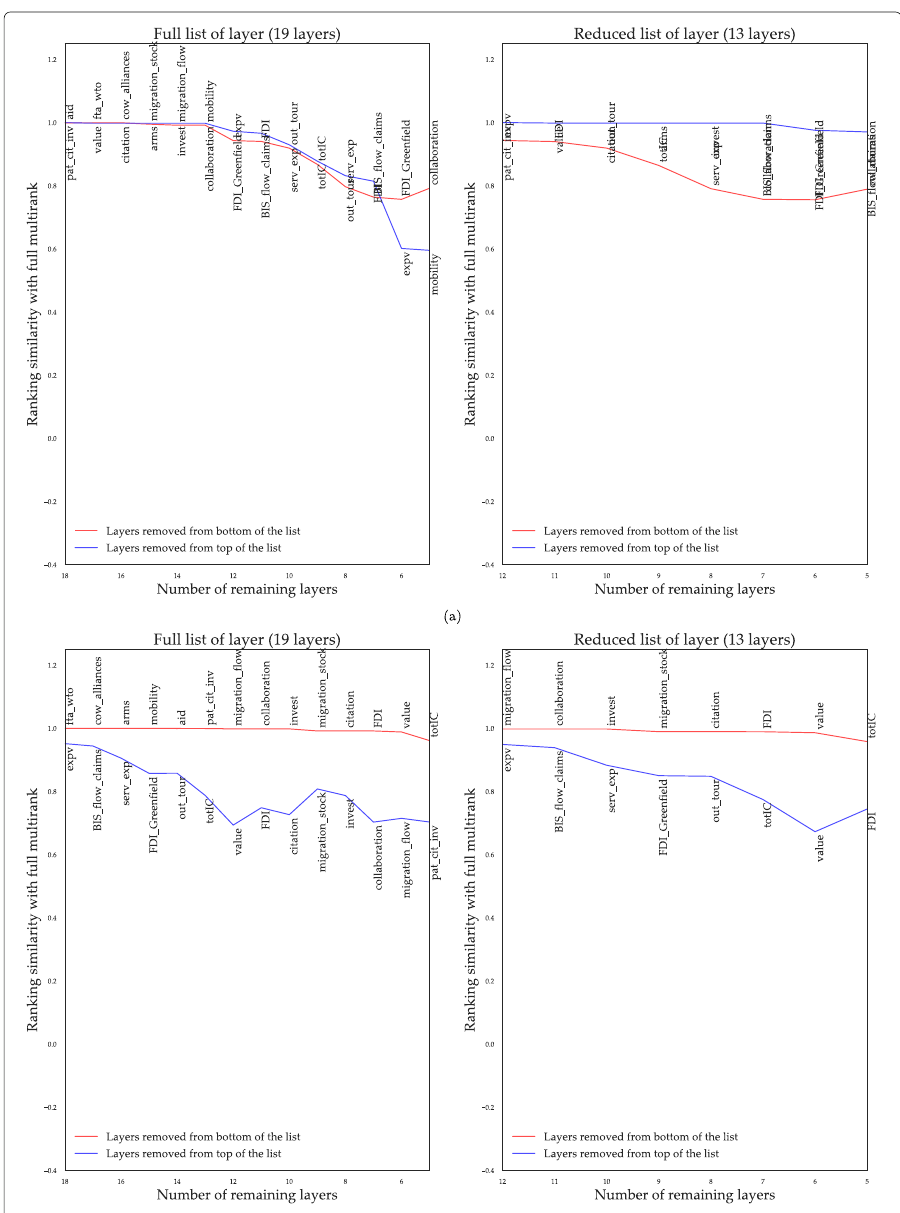
Fig. 20 Change in ranking with respect to MultiRank with parameters s = 1, γ = 1 and a = 0 ( a ) or a = 1 ( b )